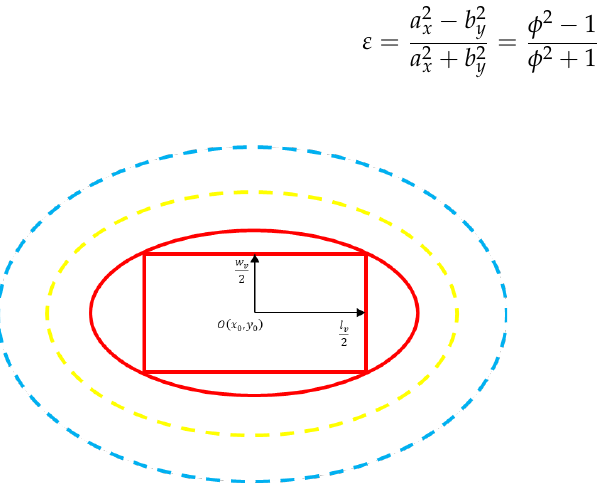
Figure 5. Static safety field overhead projection.